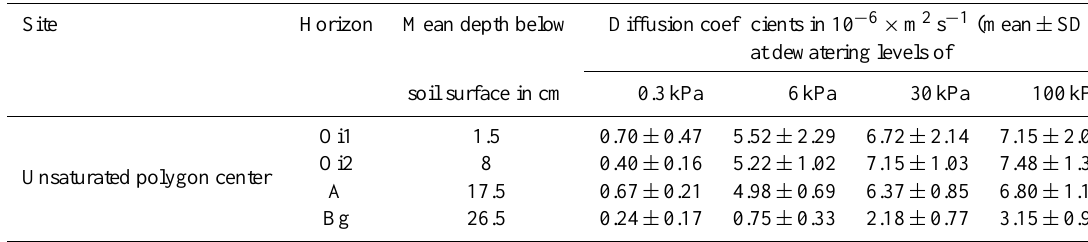
Table 3. CH 4 diffusion coefficients of an unsaturated polygon center at the different dewatering levels 0.3, 6, 30 and 100kPa at different soil depths (mean ± std, n = 3).